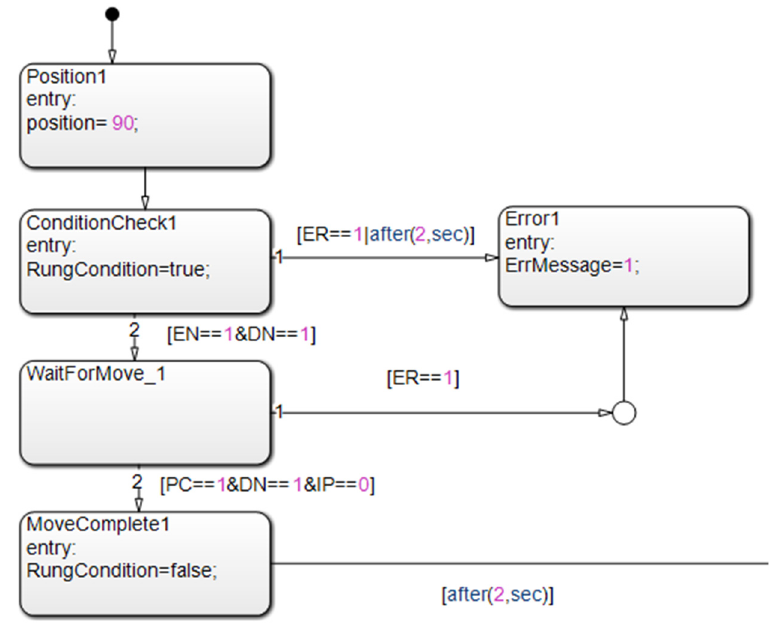
Figure 9. Sample StateFlow logic used to set position value to 90°.